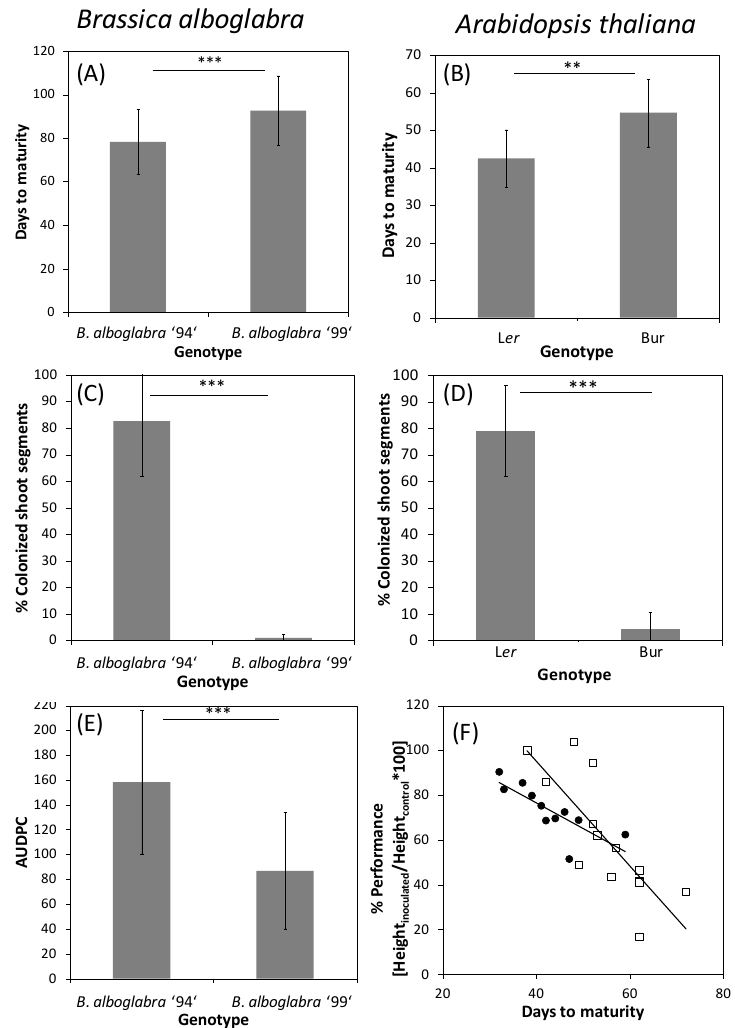
Figure 3. Developmental type and V. longisporum disease parameters of two accessions of B. alboglabra (left side) and A. thaliana (right side). ( A , B ) Development time of mock-inoculated control plants from inoculation to maturity ( B. alboglabra ) or germination to maturity ( A. thaliana ). ( A ) Single-plant data pooled from three independent experiments, N = 58 (94), N = 59 (99); ( B ) Average values from means of 9 and 11 independent experiments comprising at least 15 plants each; ( C , D ) Systemic colonization by V. longisporum . ( C ) N = 5; ( D ) N = 9 (L er ), N = 11 (Bur); ( E ) Area under the disease progress curve (AUDPC, [191]) of V. longisporum -inoculated plants. High values stand for fast disease progression. Single-plant values from six independent experiments, N = 243 (94), N = 253 (99); ( F ) Performance of L er (circles) and Bur (squares) after V. longisporum infection depending on development time (data from [188]). Development was prolonged in winter experiments under lower light intensities. Performance (%) = Height inoculated /Height control *100. Each data point represents a separate experiment comprising at least 30 plants. Experiments were performed at different seasons over three years under greenhouse conditions. Correlations: L er : r = −0.79, p = 0.004; Bur: r = −0.79, p < 0.001. Error bars denote standard deviations, asterisks denote significant differences below the 0.01 (**) and 0.001 (***) significance levels respectively (Student’s t